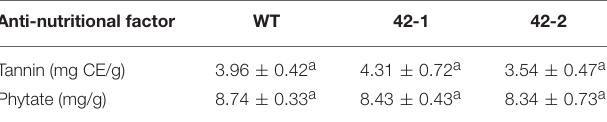
TABLE 2 | A comparison of selected anti-nutritional factors present in wild-type (WT) and transgenic sorghum genotypes 42-1 and 42-2 wholegrain flour, on a dry weight